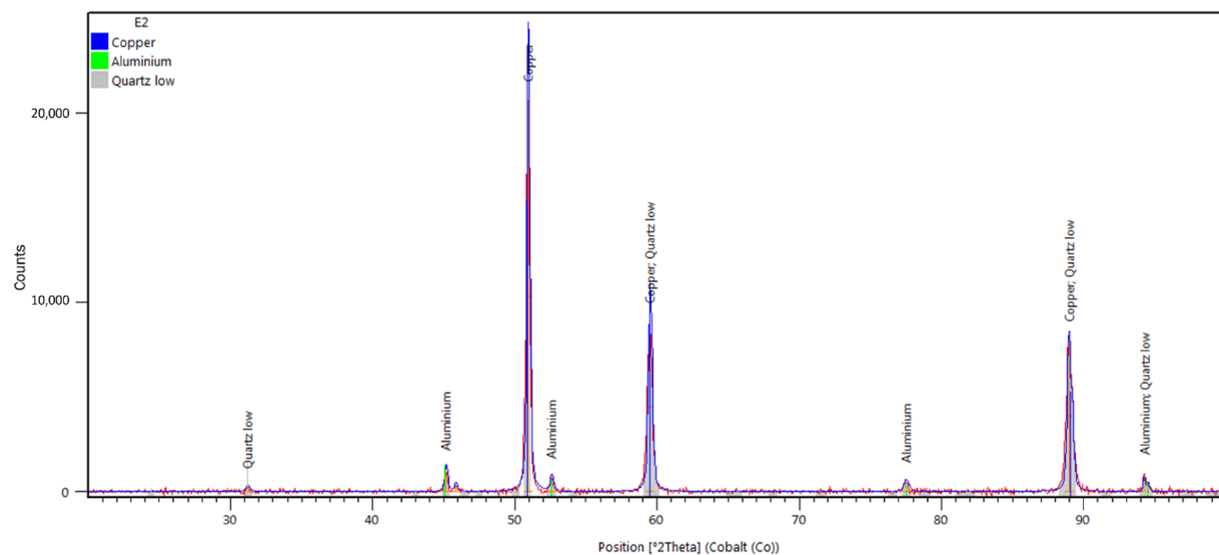
Figure 8. X-ray diffraction patterns of the intermediate.